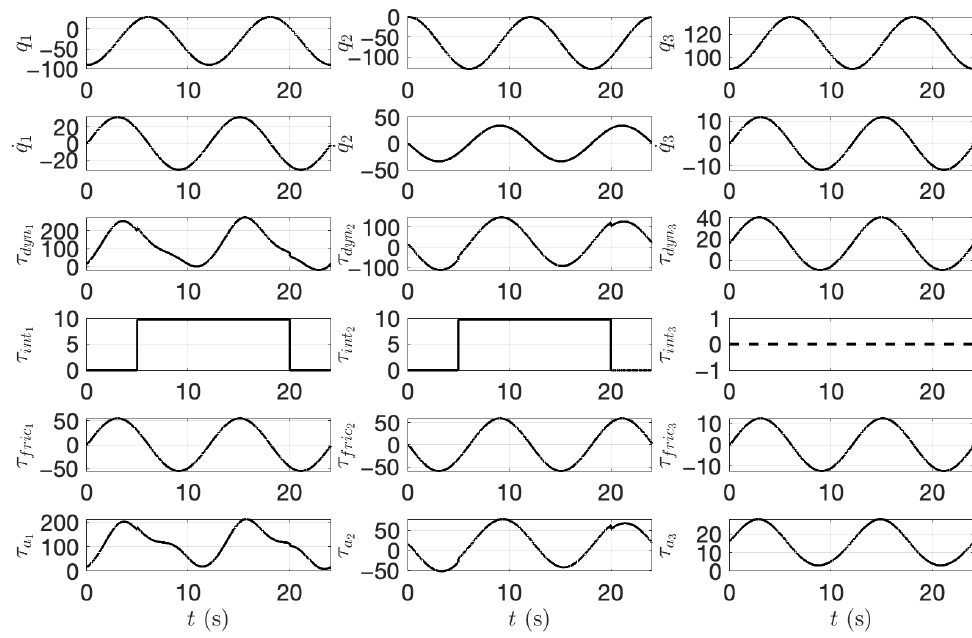
Figure 6. LLRR dynamics during a squat exercise.